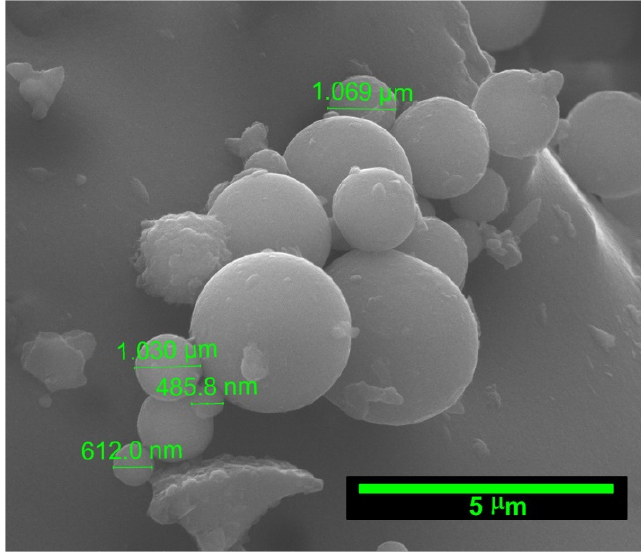
Figure 1. A view of fine fly ash particles.